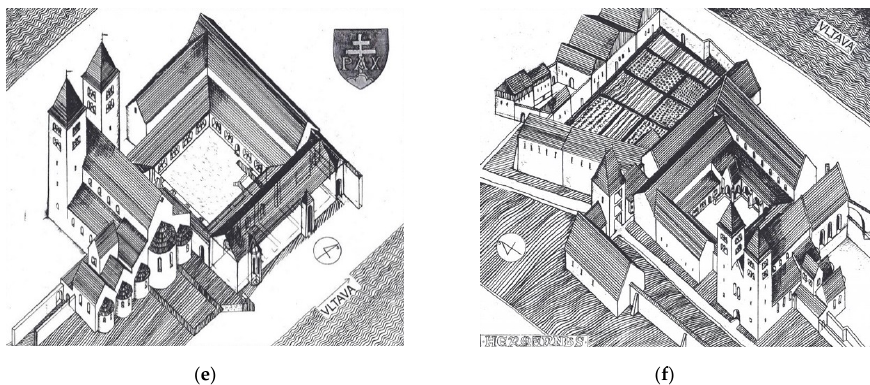
Figure 4. Examples of early maps and land-survey plans originating from archeological research: ( a ) The Second military mapping; ( b ) The cadaster mapping (Franziszeische Kataster); ( c ) The plans differentiating the structures of monastery’s Romanesque and Gothic eras; ( d ) The plan of the lost town Sekanka (Romanesque era); archaeological drawing of the monastery in Romanesque era ( e ) and in Gothic era ( f ). Source: 2nd Military Survey, Section No. 9/2, Austrian State Archive/Military Archive, Vienna ( a ); State Administration of Land Surveying and Cadaster ( b ); Miroslav Richter (1982; ( c , d )); František Stehlík (1947; original) and Jan He ř man (2009; redrawn with new notes by archeologists; ( e , f )).